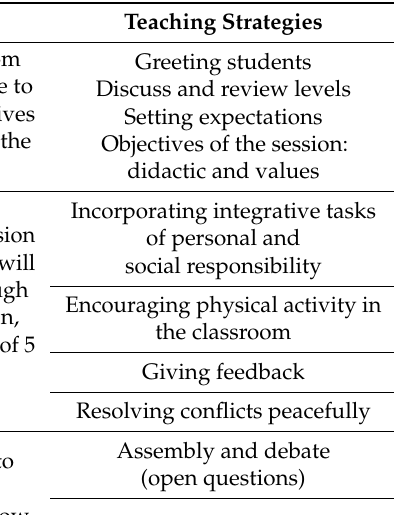
Table 3. Session structure and teaching strategies of the ACTIVE VALUES